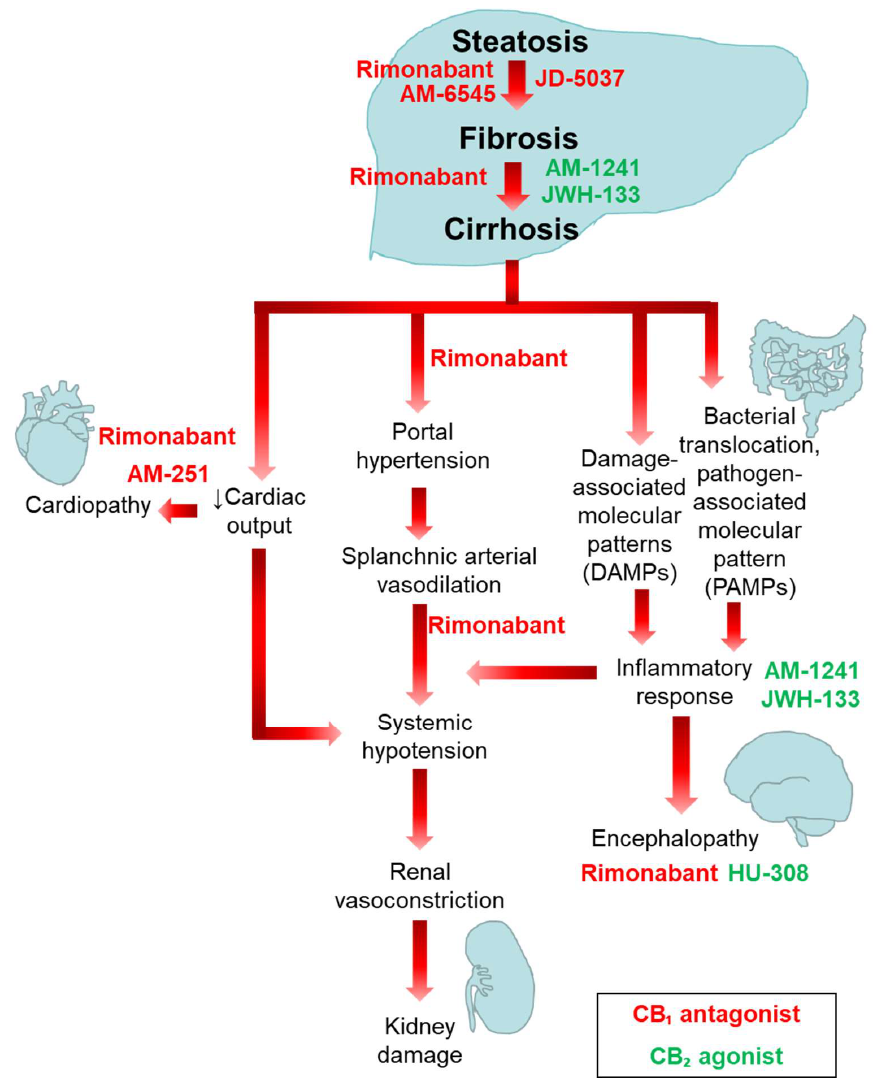
Figure 3. CB 1 antagonists and CB 2 agonists as potential drugs for the treatment of liver cirrhosis.